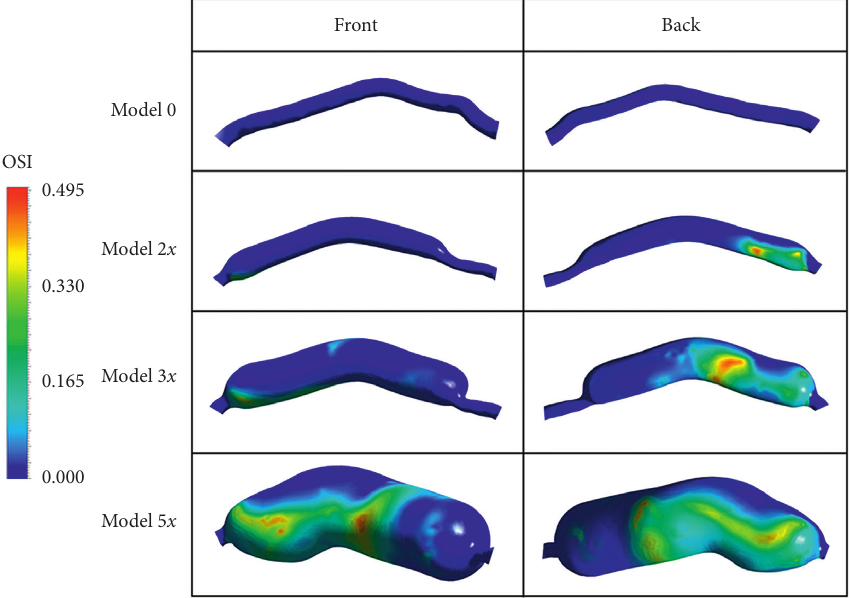
Figure 7: Oscillatory shear index (OSI) distribution in the coronary artery aneurysm for the four models. Table 3: The area of high OSI and RRT in the aneurysm and the area of aneurysm.